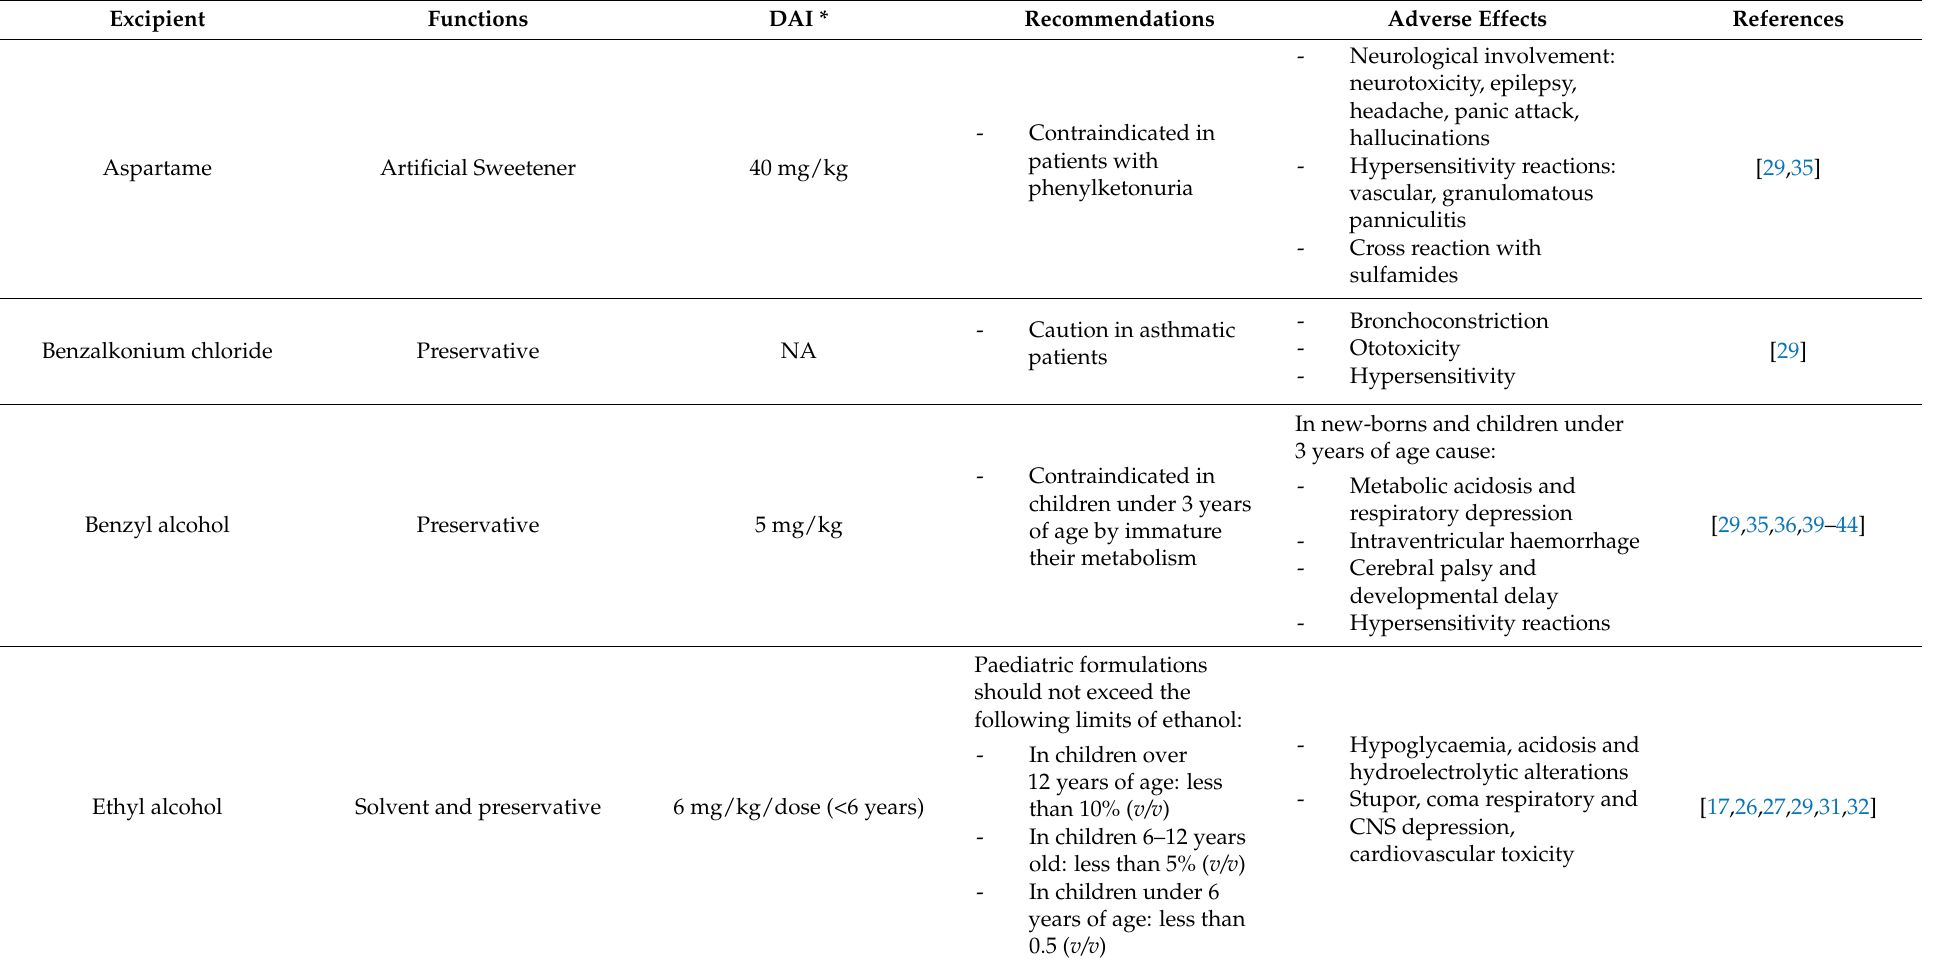
Table A1. Most important characteristics of the excipients discussed in this paper (in alphabetical